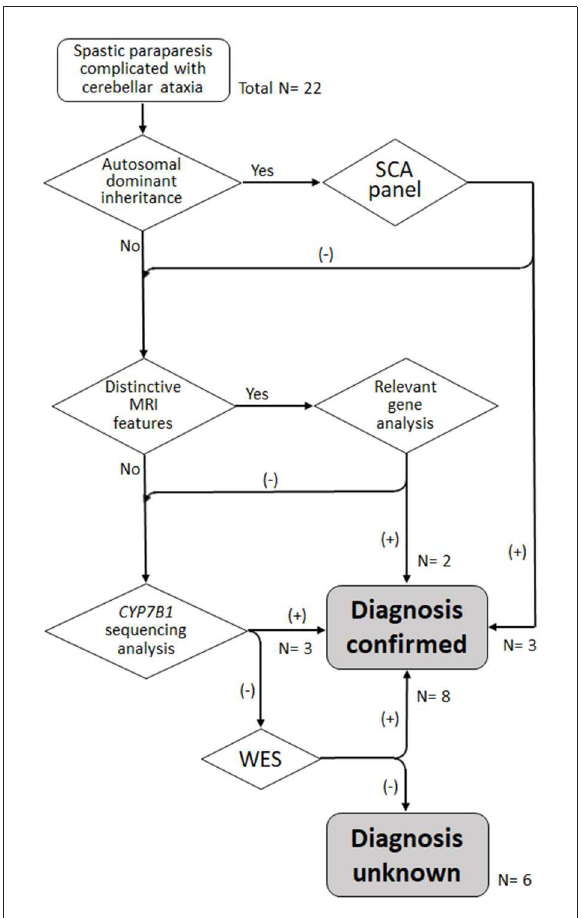
FIGURE1 Algorithm for stratified genetic testing in this study. N , number of index